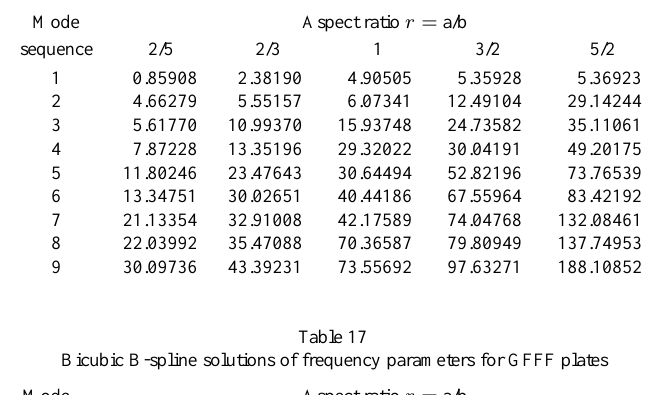
Table 16 Bicubic B-spline solutions of frequency parameters for GGFF plates